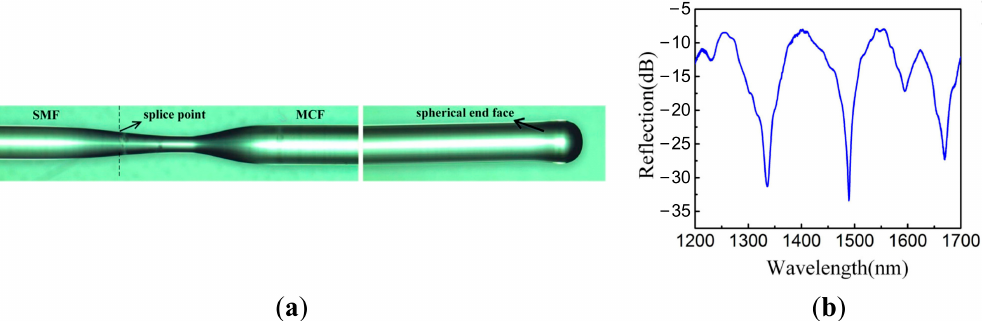
Figure 8. ( a ) Schematic of the high-temperature sensor head utilizing a seven-core fiber Michelson interferometer. ( b ) The typical reflectance spectrum of the seven-core fiber Michelson interferometer with a spherical end face [25].